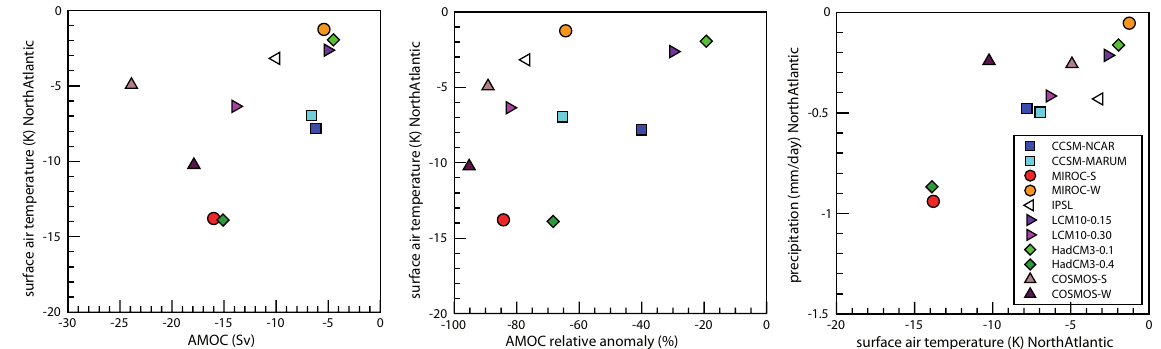
Fig. 6. Relationships for the North Atlantic extratropics, (l.h.s) between the changes (related to hosing) in mean annual surface air temperature averaged over this region and the AMOC changes, (middle panel) between the same temperature changes and the AMOC relative changes and (r.h.s) between the changes in mean annual temperatures and mean annual precipitation averaged over this region. The region for the area average is defined for longitudes between 50 and 10 ◦ W and latitudes between 40 and 60 ◦